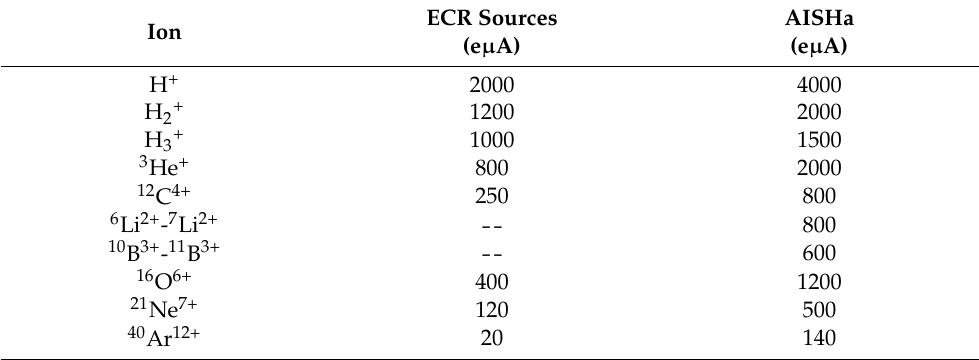
Table 3. List of ion species and related currents produced by ECR (Electron Cyclotron Reso- nance) sources presently in use at CNAO and by the new source AISHa (Advanced Ion Source for Hadron